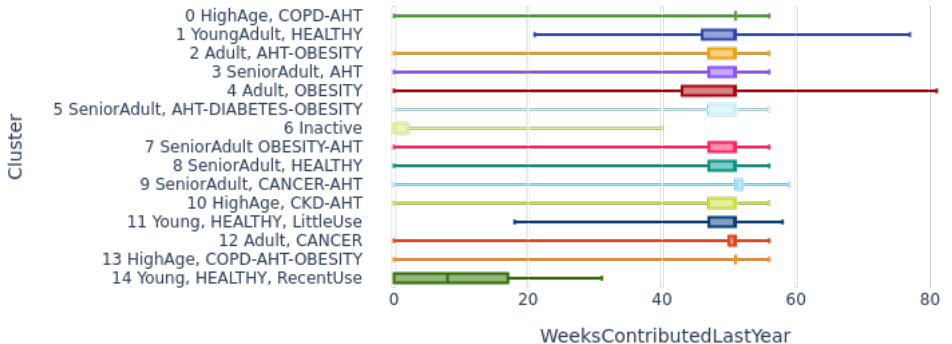
Figure 10. Distribution by cluster of weeks contributed since last year.